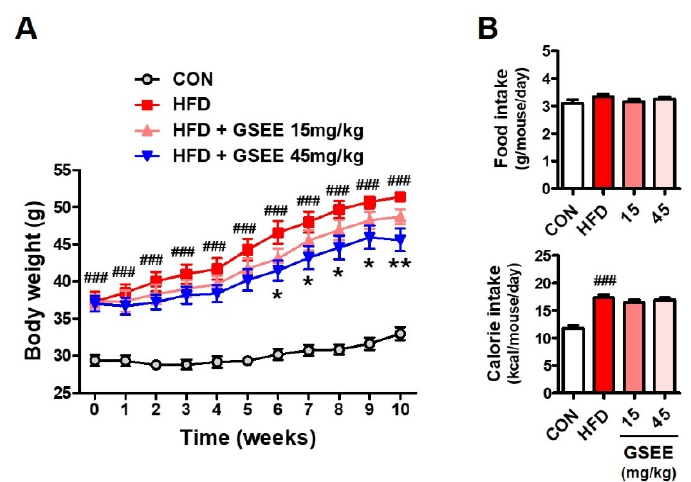
Figure 2. Effects of GSEE on the body weight in high-fat diet (HFD)-fed obese mice; ( A ) body weight changes; ( B ) food and calorie intake. Mice ( n = 8 in each group) were fed with HFD for 10 weeks with or without daily oral administration of GSEE (15 or 45 mg/kg of body weight). Values are represented as mean ± SE. Student’s t -test, ### p < 0.001 vs. control. *, ** p < 0.05, and 0.01, respectively, vs. HFD.